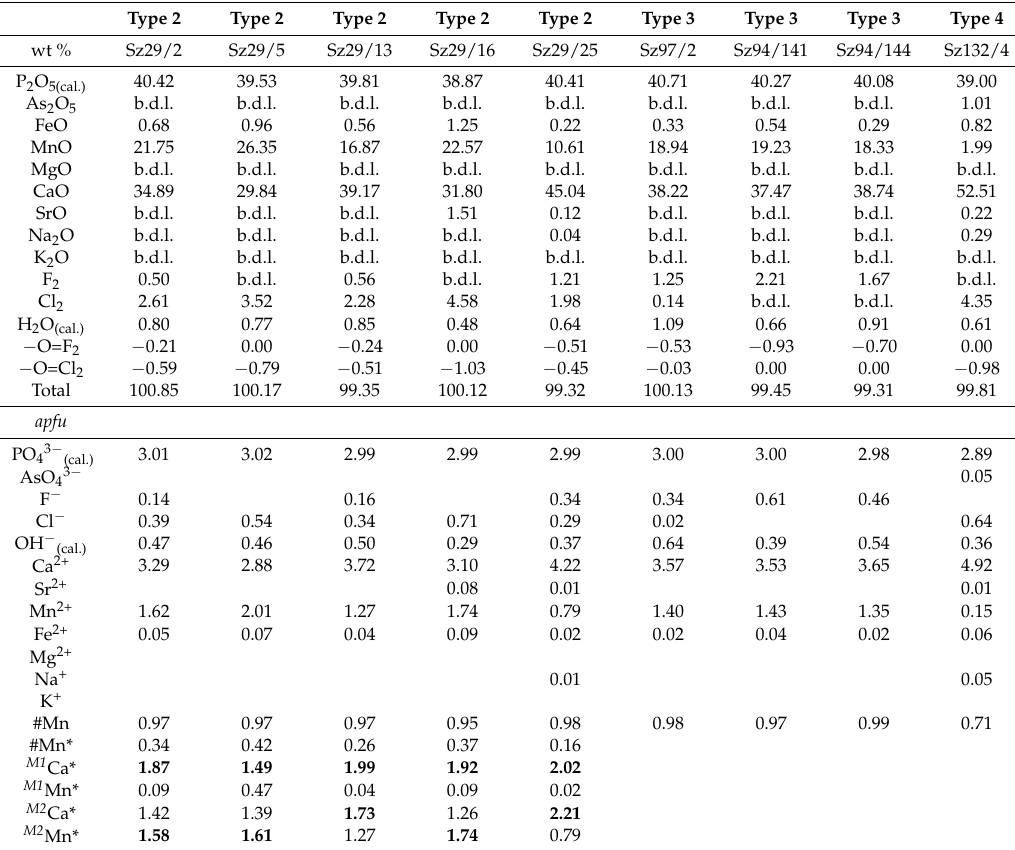
Table 3. Representative chemical compositions of Types 2–4 apatites and proposed cation distributions (dominant components are bold) between the M1 and M2 sites in Type 2 apatites from the Szklary pegmatite. Sz29/16 = sample/analysis, b.d.l. = below detection limit, Ca* = Ca + Sr + Na + K, Mn* = Mn + Fe + Mg, #Mn = Mn/(Mn + Fe) and #Mn* = Mn*/(Mn* + Ca*). Further explanations in the text.